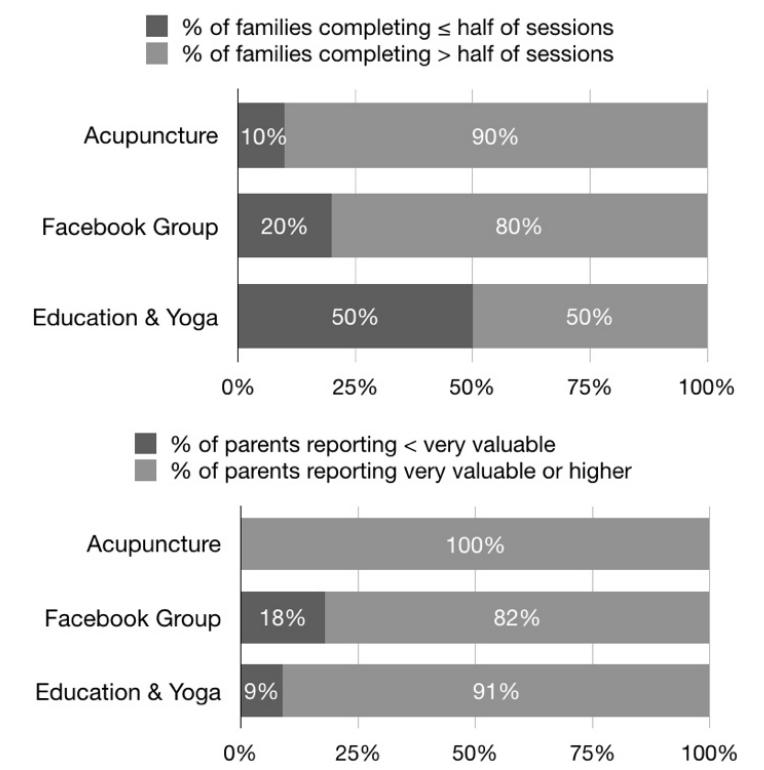
Figure 2. Summary of parent adherence and perception of values.